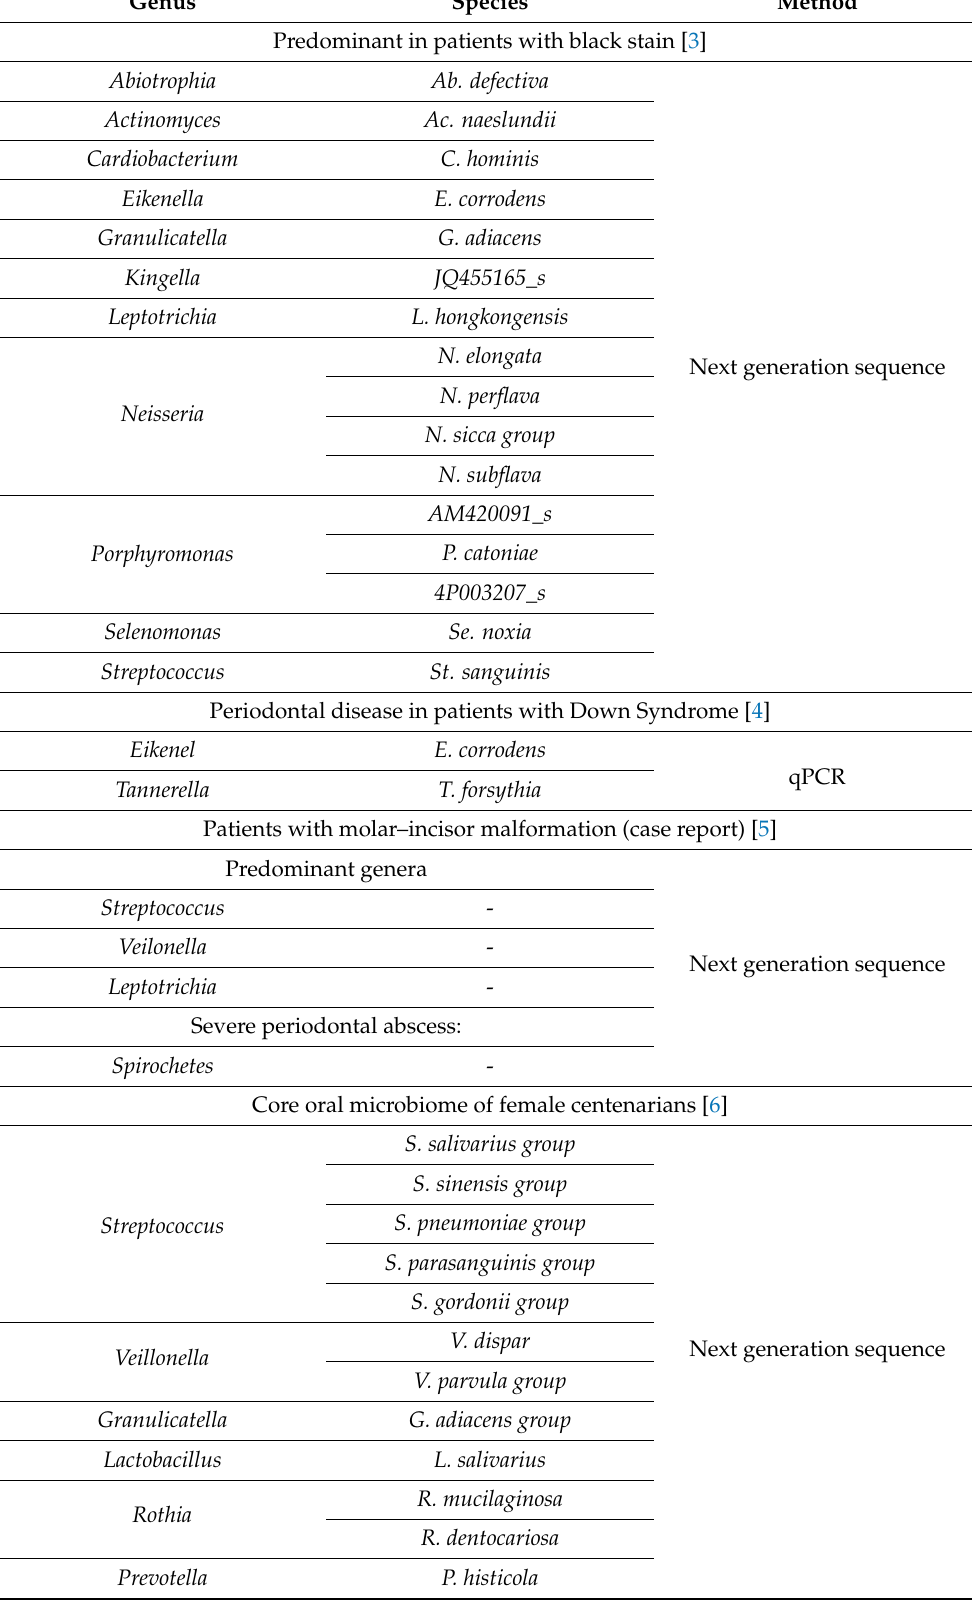
Table 1. List of the key species proposed in this